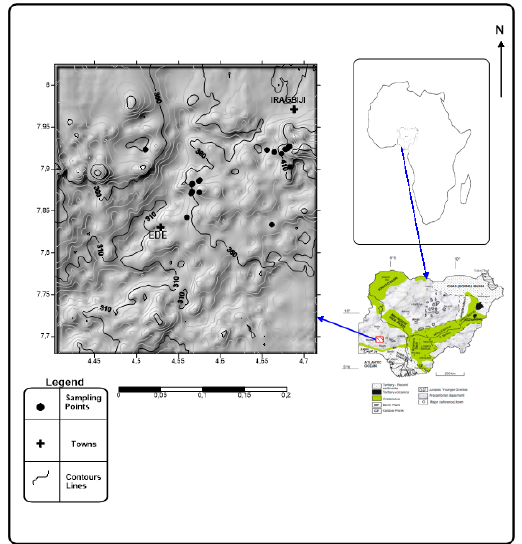
Topographical Map of the Study Area Showing Relief and Sampling Locations 2.1 Geology of the Study Area